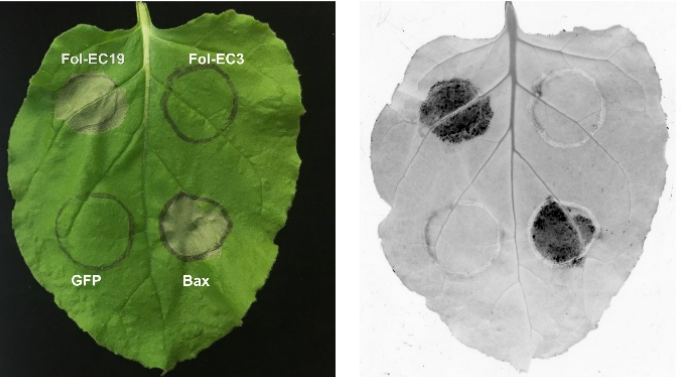
Figure 4. Fol-EC19 induces cell death in the leaves of N. benthamiana . N. benthamiana leaves were agro-infiltrated with a construct containing the Fol-EC19 effector candidate gene. GFP and Fol-EC3 served as negative controls and Bax served as a positive control. Representative leaves were photographed 3 days after infiltration and the experiment was repeated at least three times with consistent results.